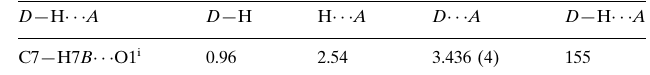
Hydrogen-bond geometry (A˚ , (cid:2)